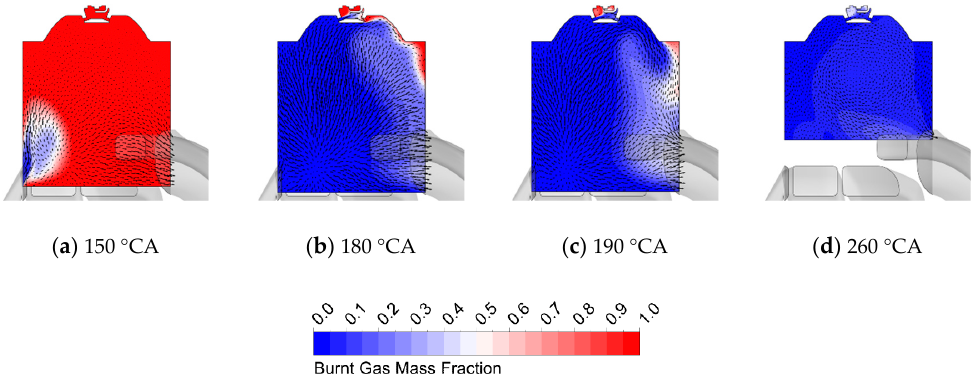
Figure 7. In-cylinder scavenging behavior at 7500 rpm and full load using PN8